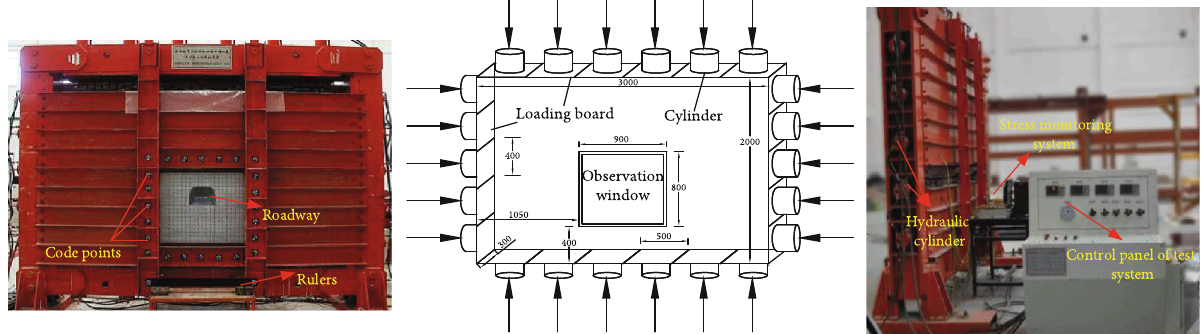
Figure 2: Model system. (a) The test model frame. (b) The model loading schematic. (c) The experiment control system and stress monitoring